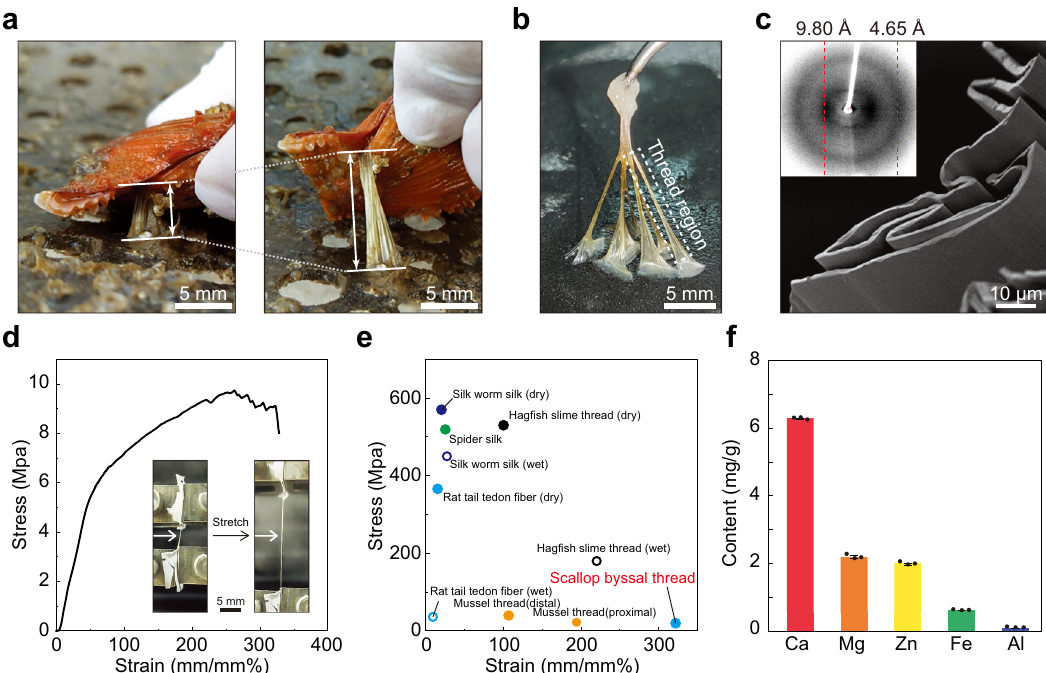
Fig. 1 Structure and mechanical properties of the native scallop byssal thread. a Photographs of marine scallop adheres to a given substrate through a byssus with a bundle of threads before and after stretching. b Photographs of a complete byssus derived from scallop. The thread region of scallop byssus is marked in dotted box. c Morphological characterization of the microscopic structure of the byssal thread by SEM. The byssal thread is composed of fi lms folded loosely and aligned along the axis of macroscopic byssus. The insert image refers to X-ray fi ber diffraction pattern of the byssal thread. The byssal thread shows a typical diffraction pattern of cross- β strands, in which the meridional re fl ection is ~4.65 Å (corresponding to the inter-sheet distance within the same layer) and the equatorial re fl ection is ~9.80 Å (corresponding to the inter-sheet distance between adjacent layers). d A representative strain- stress curve of scallop byssal thread stretched in wet condition (relative humidity ~90% and tensile speed 0.2 mm/s). The byssal thread shows high extensibility reaching up to 327 ± 32%. The insert images show the byssal thread before and after stretching. e The extensibility comparison of scallop byssal thread and several biogenic threads derived from diverse of creatures underwater or on the earth. The scallop byssal thread shows the highest extensibility, which serves a benchmark for high extensible materials. f Quantitively analysis of metal elements in the byssal thread by ICP-MS. Among these polyvalent metals, calcium accounts for the largest proportion in thread region (55.75%). Data are presented as mean values± SEM. n = 3 biologically independent